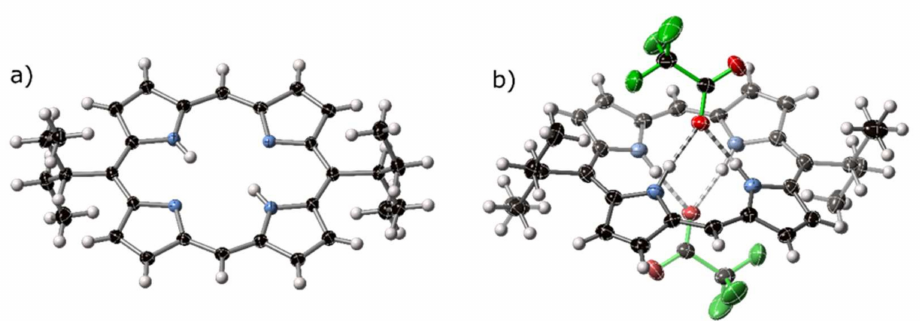
Figure 6. ( a ) View of the molecular structure of H 2 13 in the crystal structure of H 2 13 · 1 / 3 CH 2 Cl 2 . ( b ) The ‘ cis ’-type hydrogen bonding pattern of [H 4 13 ][CF 3 CO 2 H] 2 . Trifluoroacetate anions are highlighted with green bonds, with H-bonding denoted with striped bonds. Thermal ellipsoids are shown at